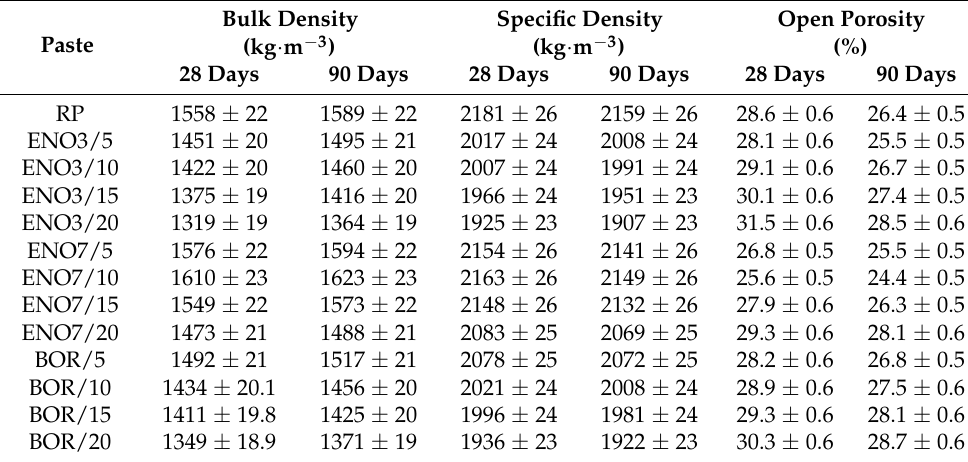
Table 12. The basic material properties of tested mixtures.